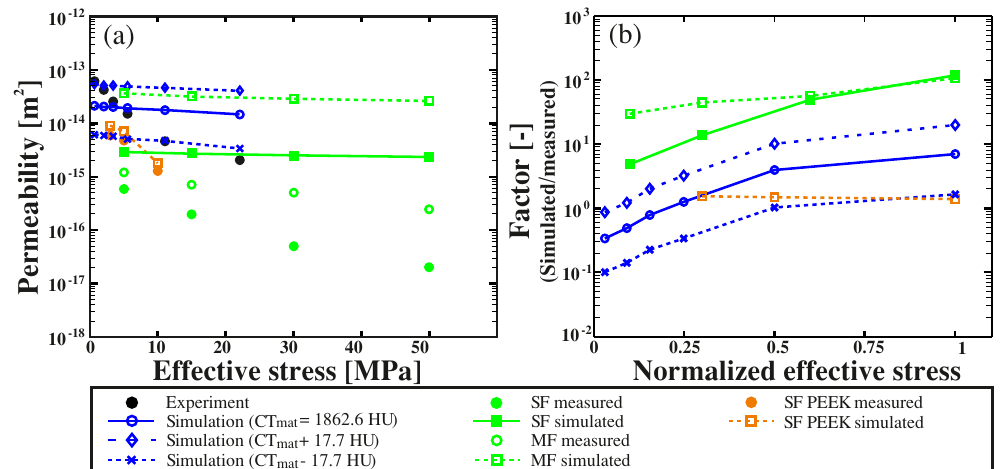
Figure 8. Comparison of experimental and simulated data of the sandstone sample with results obtained from the literature using CT tech- nology to realize simulations (Watanabe et al., 2011, 2013). Literature data are based on a three granite core samples with a single tensile fracture (SF), multiple, natural fractures (MF) and a single tensile fracture measured by using an improved core holder (SF PEEK). Further- more, the effectiveness of the simulations is shown in (b) as factors, describing the discrepancy between each simulated and corresponding experimental permeability value, versus the normalized effective stresses depending on the highest stress stage applied during the associated